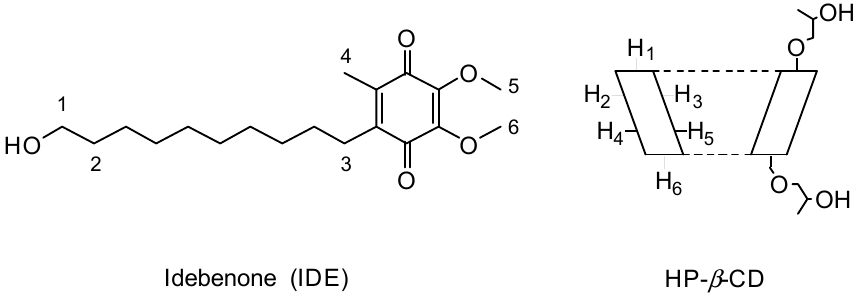
Figure 11. Structure of IDE and schematic structure of HP- β -CD. The numeration of IDE and HP- β -CD group is arbitrary for simplicity.